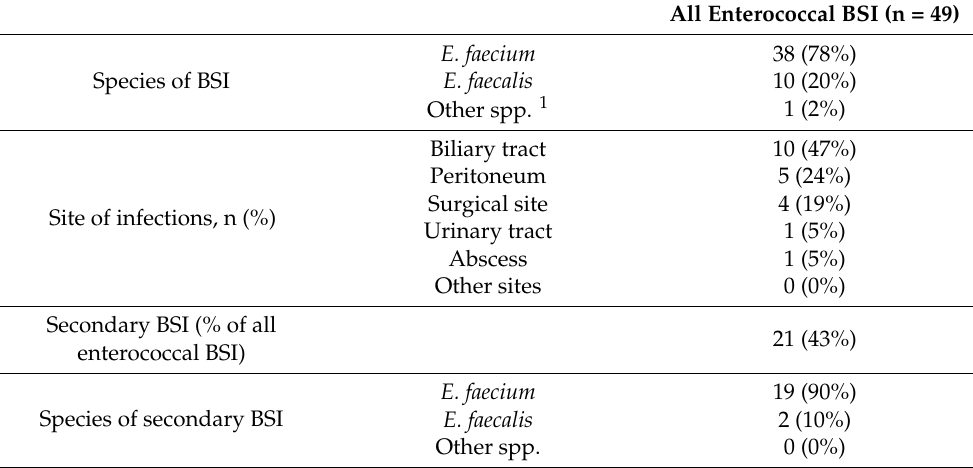
All Enterococcal BSI (n = 49) E.